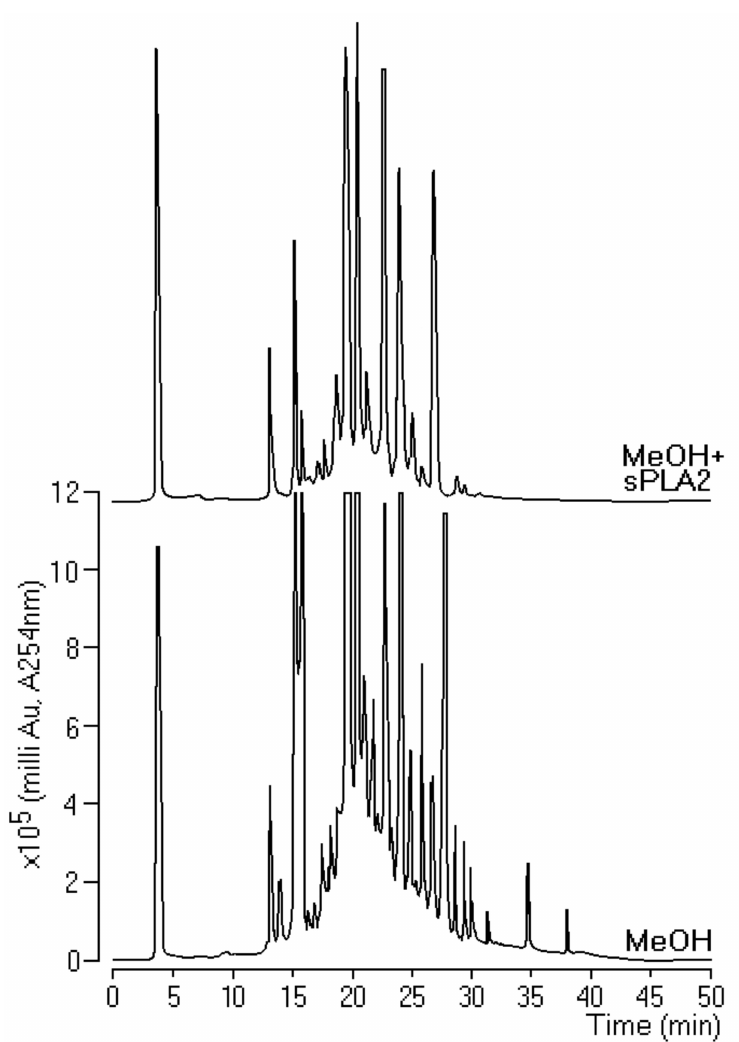
Figure 3. Reverse-phase HPLC analysis using an analytical Phenomenex C5 column where we incubated 10 µ L of pure sPLA2 (1 mg / mL) with 10 µ L of extract (0.1 mg / mL) at a ratio of 1:1 ( v : v